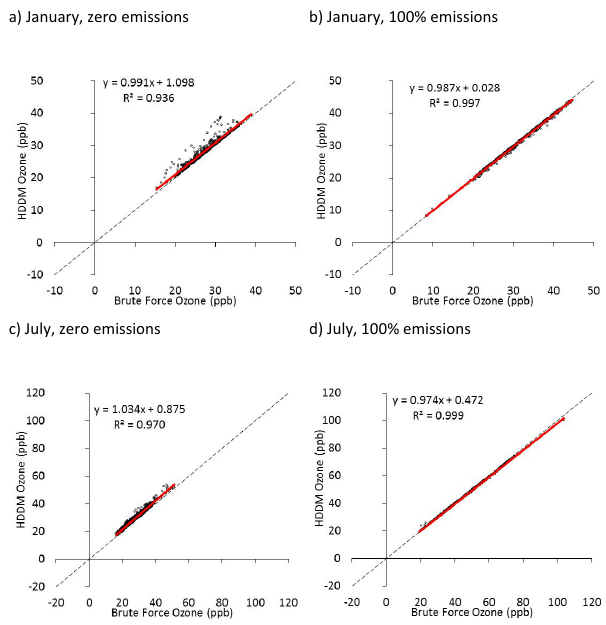
Fig. 7. Same as Fig. 5 but for the rural Weatherford location.